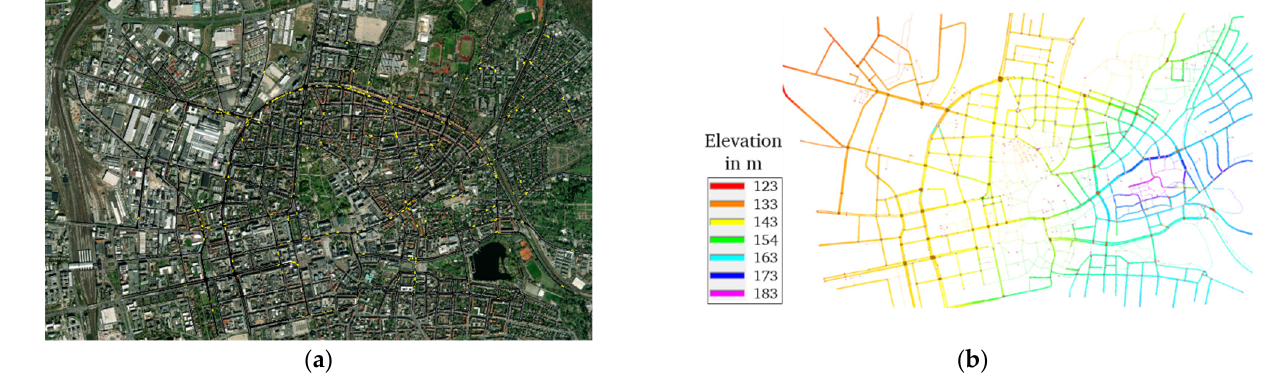
Figure 2. The modeled area of the city center of Darmstadt, Germany is shown in ( a ). The integrated elevation profile is shown in ( b ).